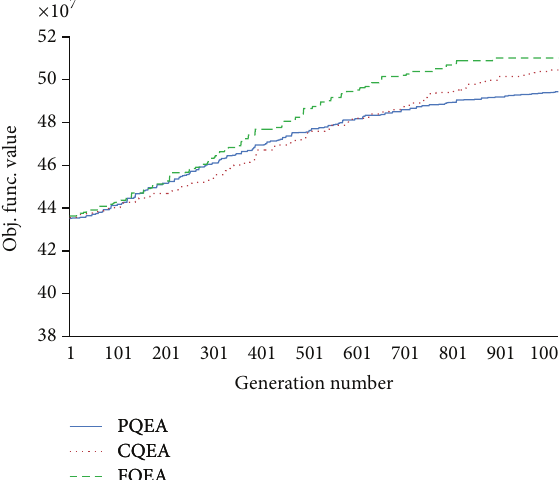
Figure 12: Convergence graph of PQEA, CQEA, and FQEA on COUNTSAT problem size, 𝑛 , being